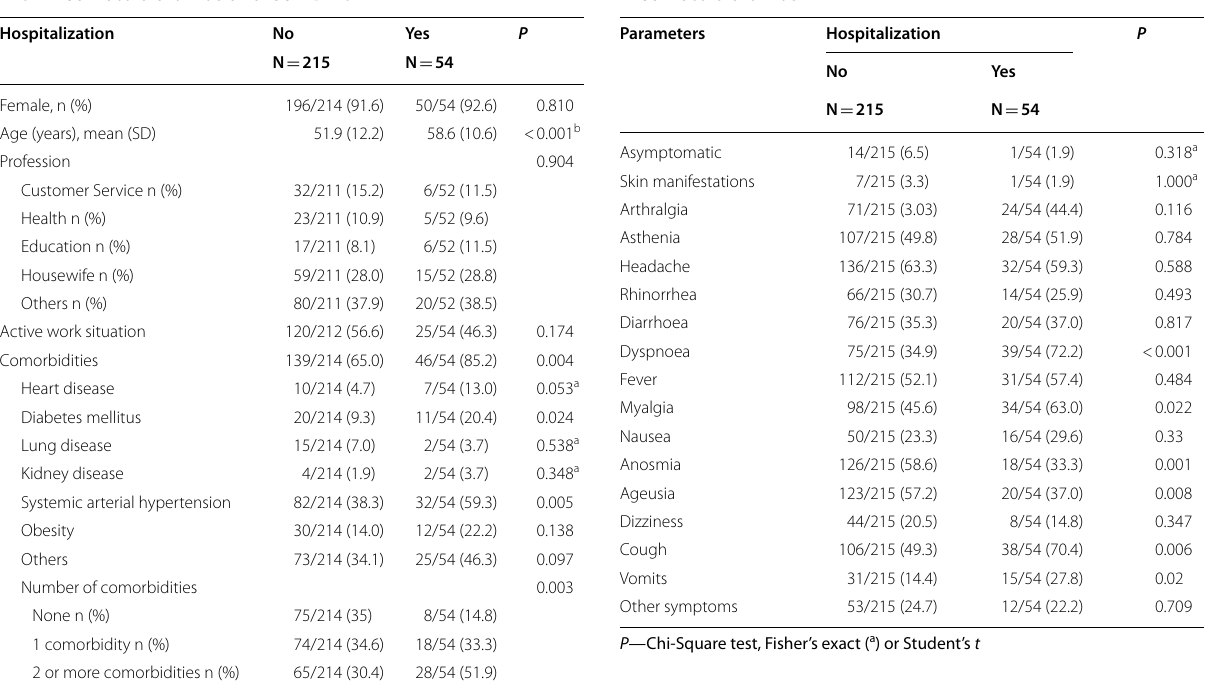
Table 2 Symptoms related to COVID‑19 in patients with